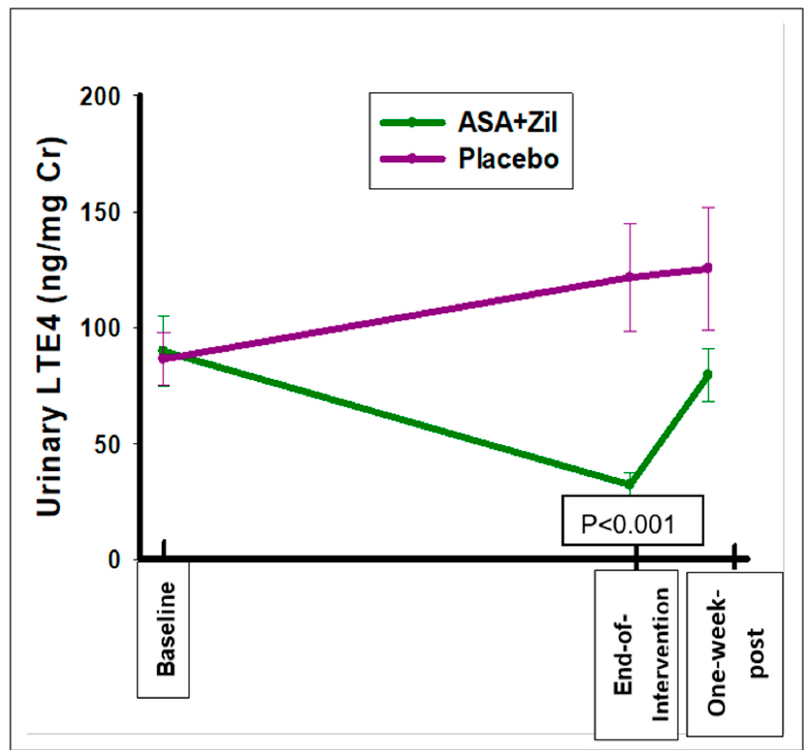
Figure 3. Baseline and changes in urinary LTE4 levels at baseline, end-of-intervention, and one-week post-intervention time points.